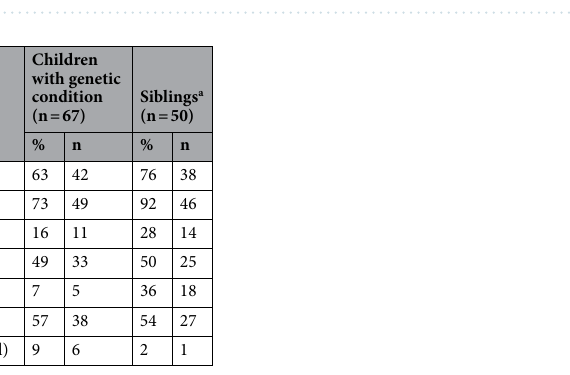
Table 3. Reasons for disclosure. Note all items were multiple-choice answers. a This number reflects the number of respondents who answered that they had disclosed information to the siblings of affected children in questionnaire I.